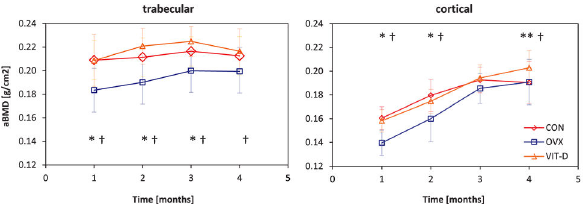
Figure 4. DXA-based aBMD changes over the 4 months study period in CON, OVX and VIT-D groups in both trabecular and cortical bone tissues (* indicates significance between CON and OVX groups, ** denotes significance between CON and VIT-D groups, † indicates significance between the OVX and VIT-D groups).